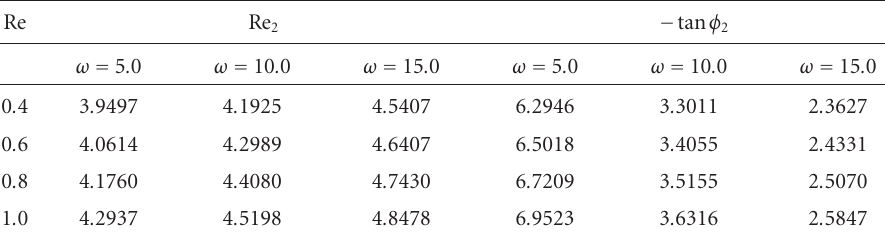
Table 4.3. Shear stress due to